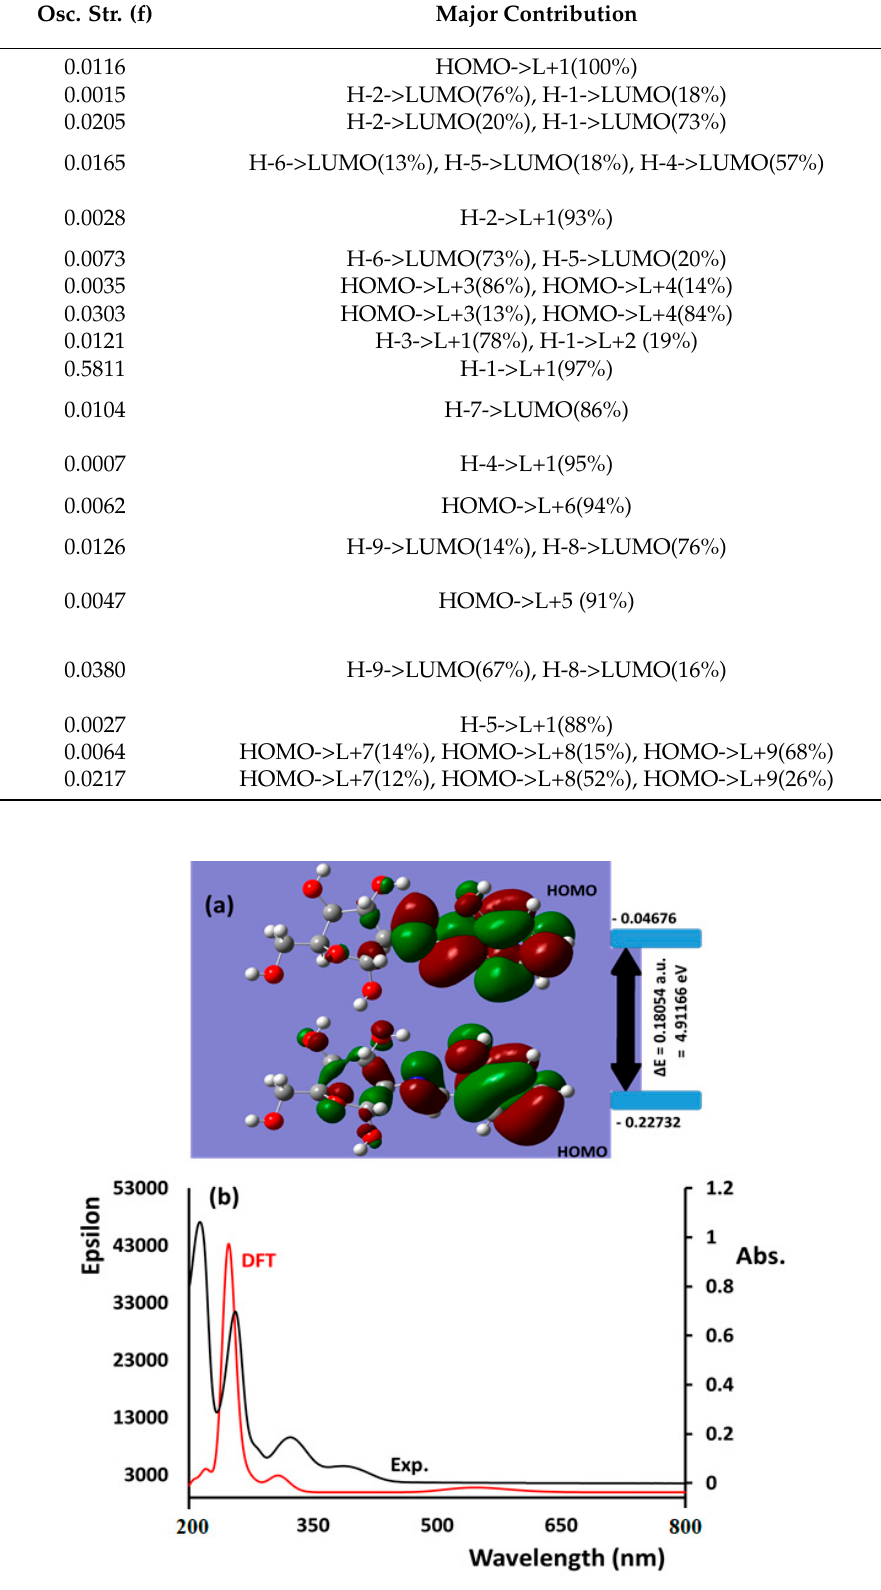
Figure 8. ( a ) LUMO/HOMO, and ( b ) Abs./TD-DFT spectra in water and acetonitrile.